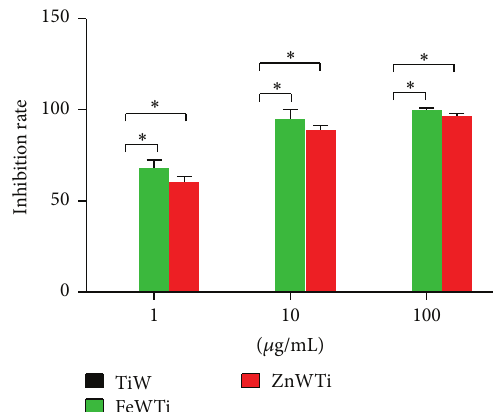
Figure 5: Polyoxometalates FeWTi and ZnWTi suppress the degranulationofmastcells.Mastcellswerestimulatedbyionomycin and PMA with or without different doses of TiW, FeWTi, or ZnWTi for 1 hour; the concentrations of histamine in supernatant were measured by ELISA. The inhibition rate was calculated by comparing the histamine expression of mast cells treated with different chemicals to mast cells treated with completed media. ∗ 𝑝 < 0.05 compared to mouse treated with TiW. Data are representative of 3 experiments.